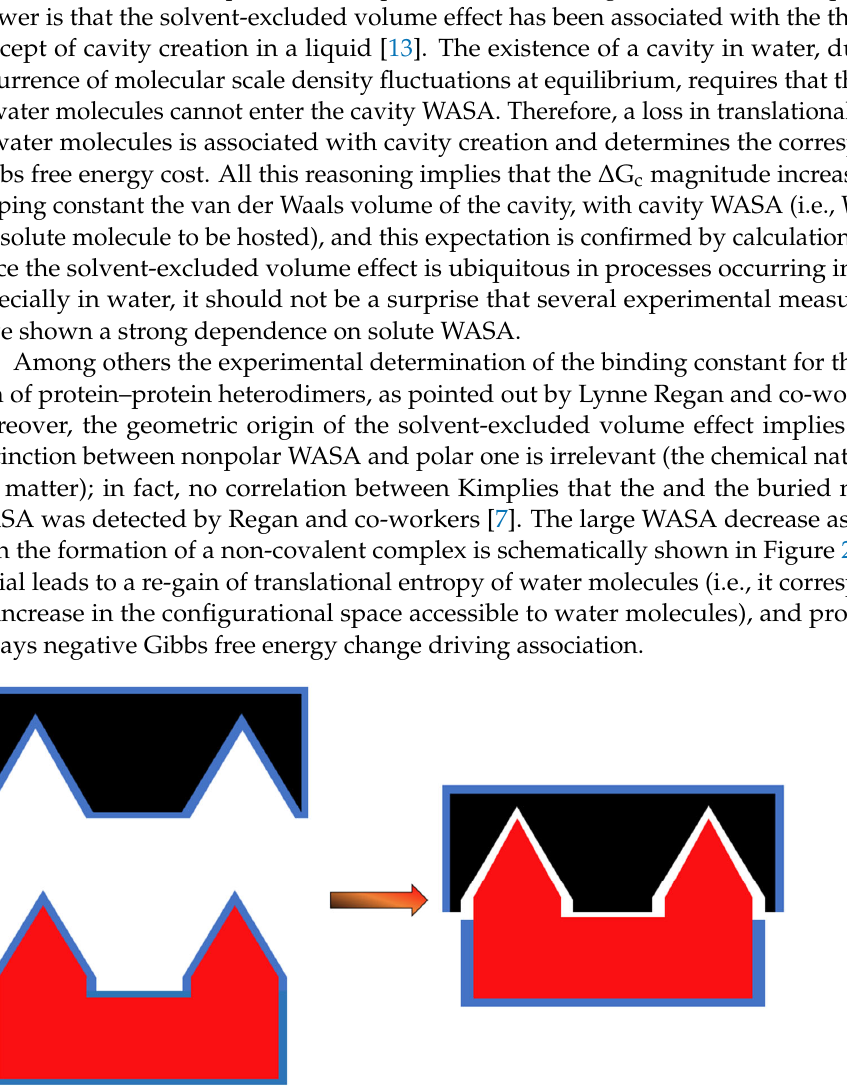
Figure 2. Picture showing the formation of a non-covalent heterodimer through the contact packing of two complementary surfaces. The blue shell represents WASA; the latter markedly diminishes upon association.